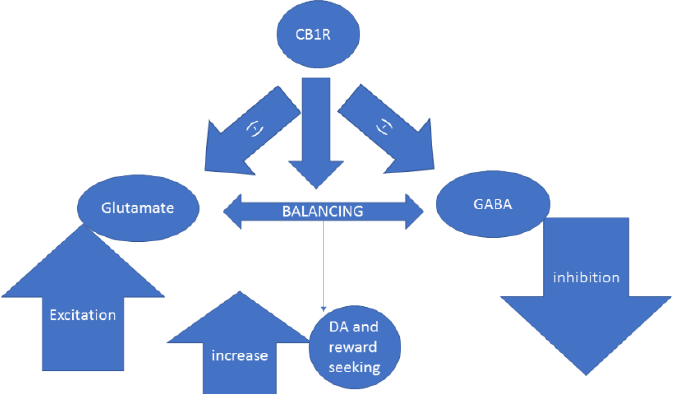
Figure 2. Activation of CB1R in the striatum facilitates glutamatergic and GABAergic balance through inhibition of overshooting which, in turn, increases DA neural activity and reward seeking behavior, pointing to its critical location.